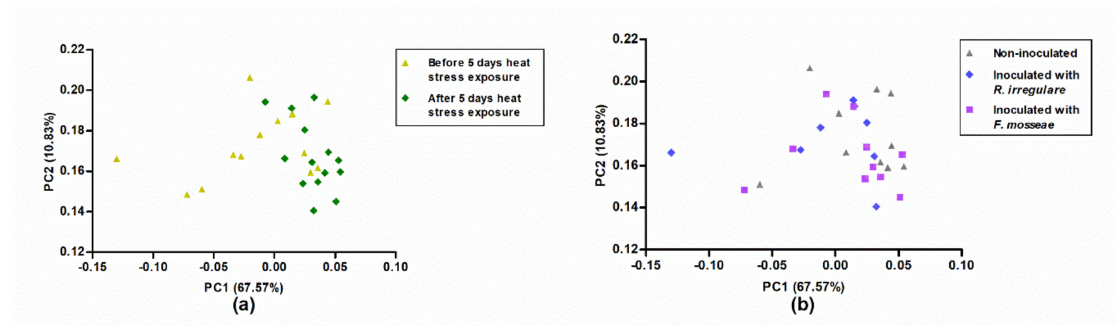
Figure 6. Score plot of plant samples in the plane defined by principal components 1 (PC1) and 2 (PC2) considering ( a ) exposure to elevated temperatures, before and after five days heat stress exposure, or ( b ) di ff erent mycorrhizal inoculation treatments, i.e., non-inoculated, inoculated with R. irregulare or inoculated with F. mosseae